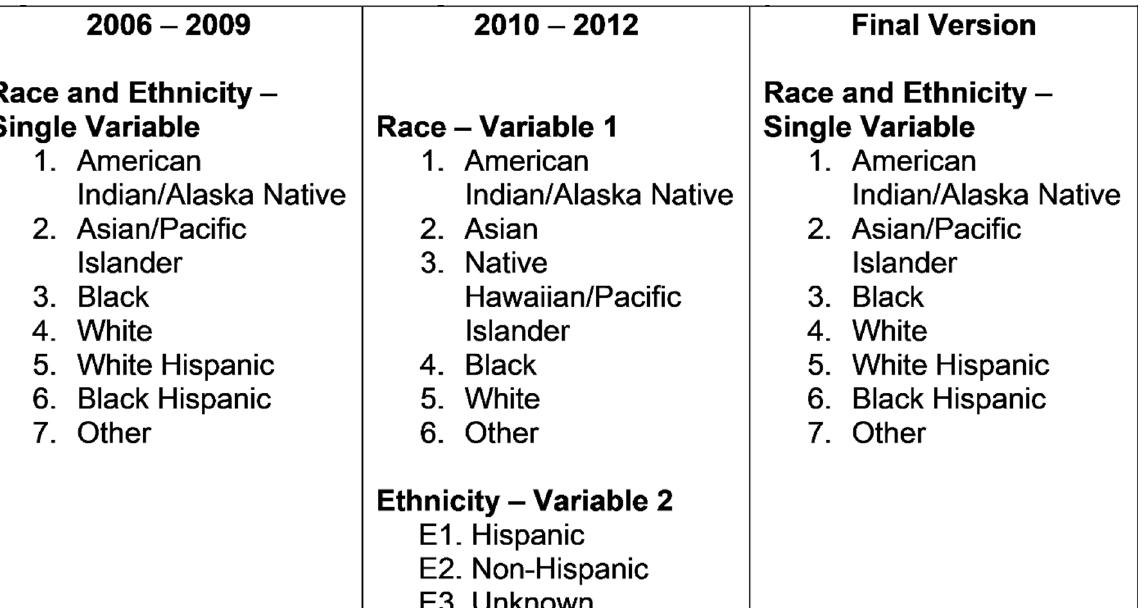
Figure 4: Example of data changes – race and ethnicity 2007–2009 to